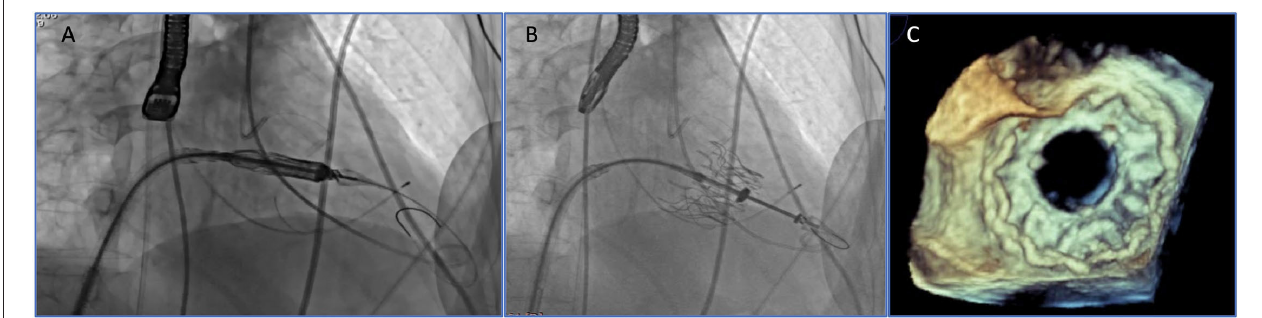
FIGURE 2 | Transfemoral TMVI: cardiovalve device before (A) and after implantation (B,C)